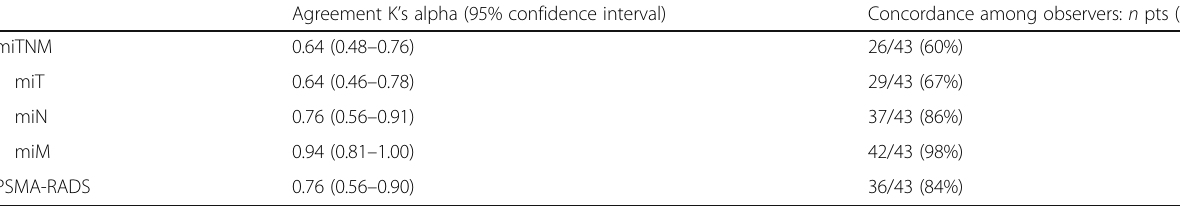
Table 2 Observers ( n = 3) agreement for miTNM and PSMA-RADS